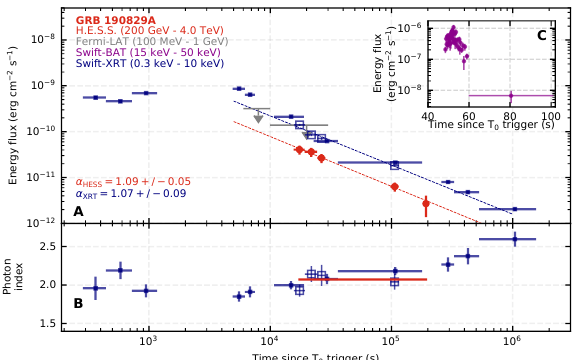
Figure 24. GRB190829A: multi-wavelength light curves ( A ) (upper panel) and photon index evolution (bottom panel) in the X-ray, HE and VHE band ( B ). The BAT prompt light curve is shown in the inset ( C ). From